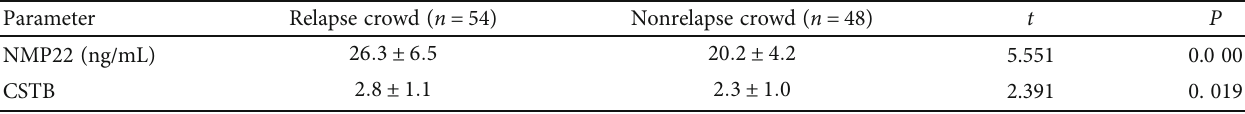
Table 1: Contrast by general data between the two crowds ( mean ± SD ).